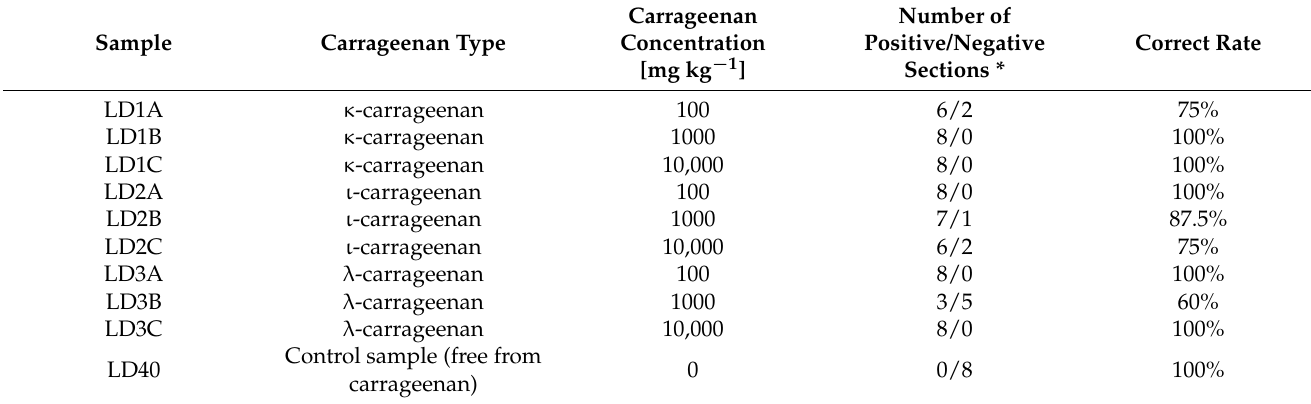
Table 2. Limit of detection for Human Inspection.